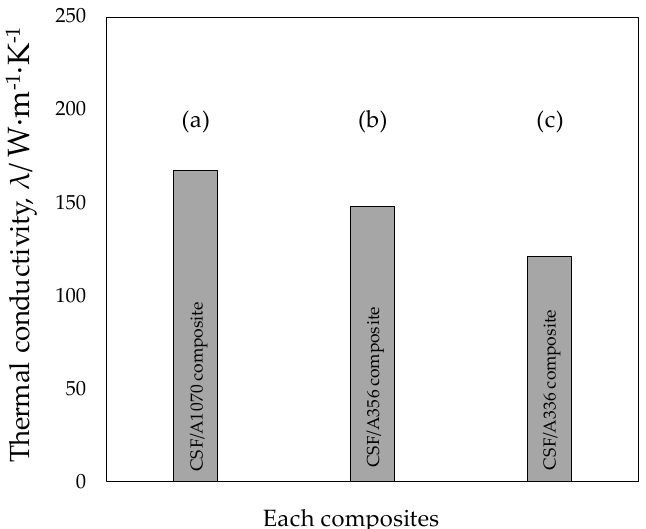
Figure 10. Thermal conductivity of Ni plated CSF/Al matrix composites: ( a ) Ni plated CSF/A1070 composite, ( b ) Ni plated CSF/A356 alloy composite and ( c ) Ni plated CSF/A336 alloy composite.